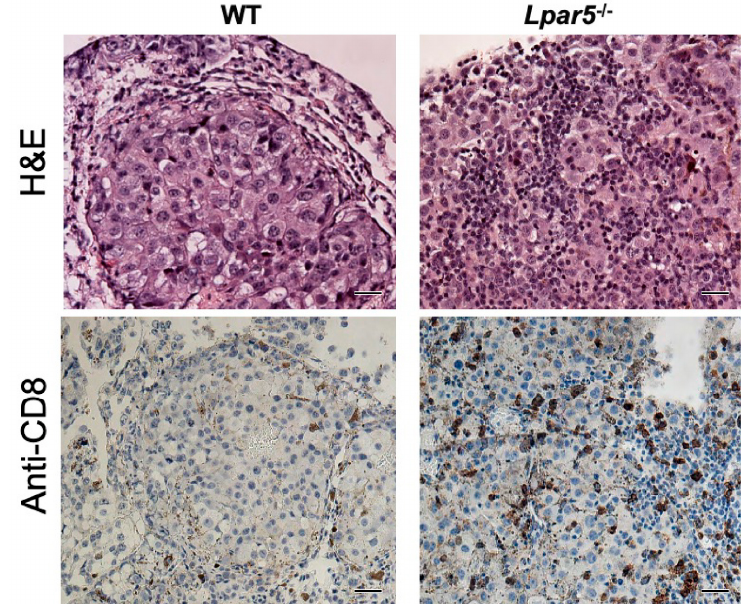
Figure 2. Increased infiltration of CD8 + T cells in lungs of Lpar5 − / − mice compared to wild type mice (WT). In the few Lpar5 − / − mice ( n = 3 out of 12 mice) that had low numbers of metastatic tumors, higher incidence of lymphocyte infiltration was observed and positively stained for CD8. No or lesser lymphocyte infiltration was seen in wild type littermates. Scale bar (50 µm), 200× magnification.